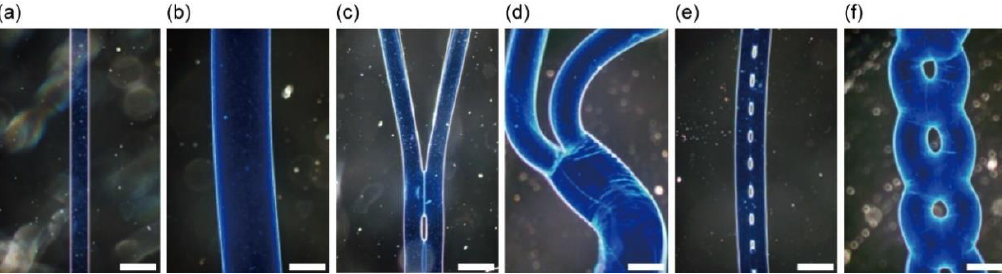
Figure 6. Alginate microfibers with various shapes: ( a , b ) single-threaded fibers formed in a combined flow regime ( a ) I and ( b ) II; ( c , d ) branched fibers formed in flow regimes changing from ( c ) combined flow regime I to separated flow regime I, and ( d ) combined flow regime II to separated flow regime II; ( e , f ) Chained fibers formed in chained flow regime ( e ) I and ( f ) II. Scale bars are 500 µm.